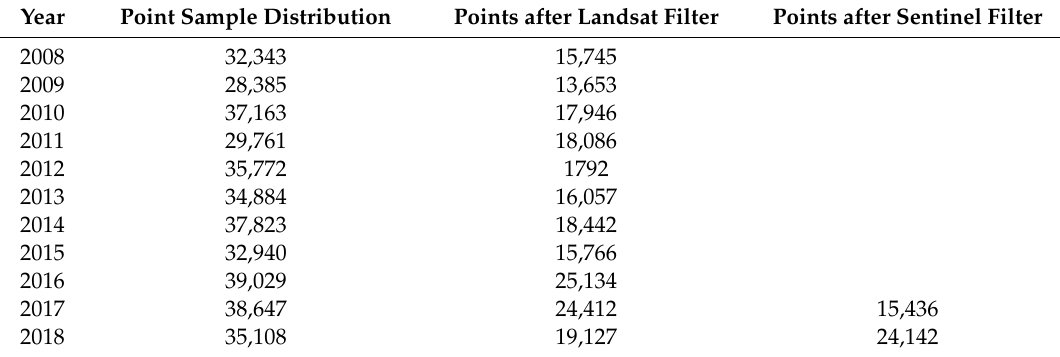
Table 2. Distribution of sampled points. The sampling design created a balanced sample across space and time. The “Point Sample Distribution” column provides the number of points by year. The “Points after Landsat Filter” column provides the final number available for the Landsat analysis after filtering on the condition that each point must have one clear observation each month from May to September. The “Points after Sentinel Filter” column provides the final number available for Sentinel-2 analysis after filtering on the condition that each point must have one clear observation in each biweekly period from May to